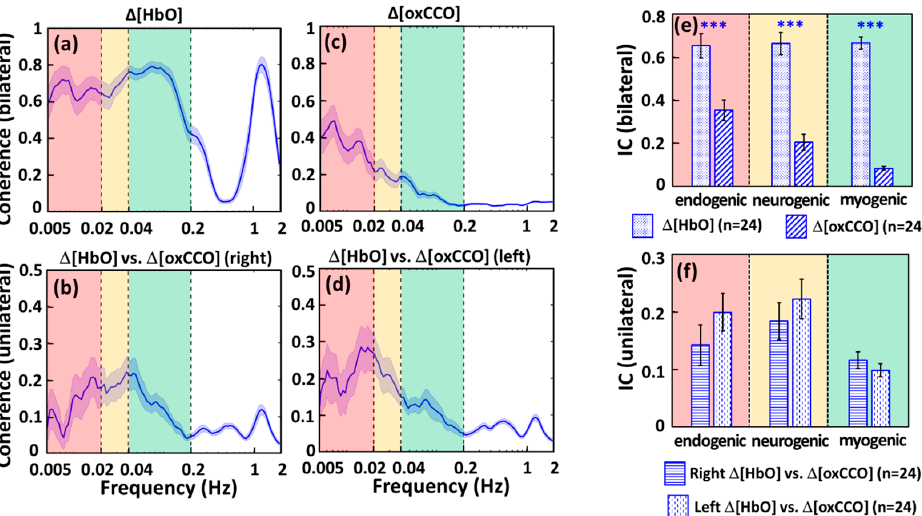
Figure 2. WTC-derived, resting-state coherence spectra at the group level (n = 24) are shown between ( a ) bilateral prefrontal Δ [HbO], ( b ) unilateral Δ [HbO] and Δ [oxCCO] on the right prefrontal side, ( c ) bilateral prefrontal Δ [oxCCO], and ( d ) unilateral Δ [HbO] and Δ [oxCCO] on the left prefrontal side. The blue-shaded band along with each spectrum marks the respective standard error of the mean. The red-, yellow-, and green-shaded boxes denote the endogenic, neurogenic, and myogenic frequency bands, respectively. Furthermore, spectrally averaged Indexes of Coherence (IC) are plotted at each ISO frequency band for ( e ) bilateral Δ [HbO] and bilateral Δ [oxCCO] and ( f ) unilateral interplay/coherence between Δ [HbO] and Δ [oxCCO] for each side of the prefrontal cortex at rest. Error bars indicate the standard error of the mean ( n = 24). “***” indicates significant differences at p < 0.0001 based on paired t -tests.